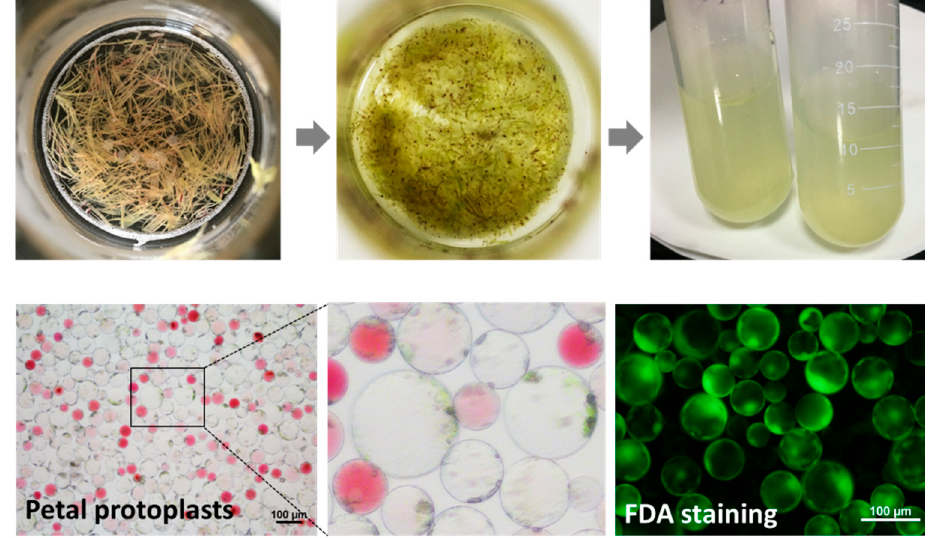
Figure 4. Protoplast isolation from the flower petals of Cymbidium orchids.